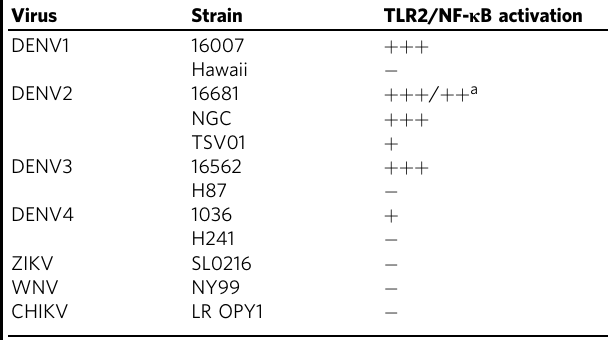
Table 2 TLR2 engagement by DENV is strain speci fi